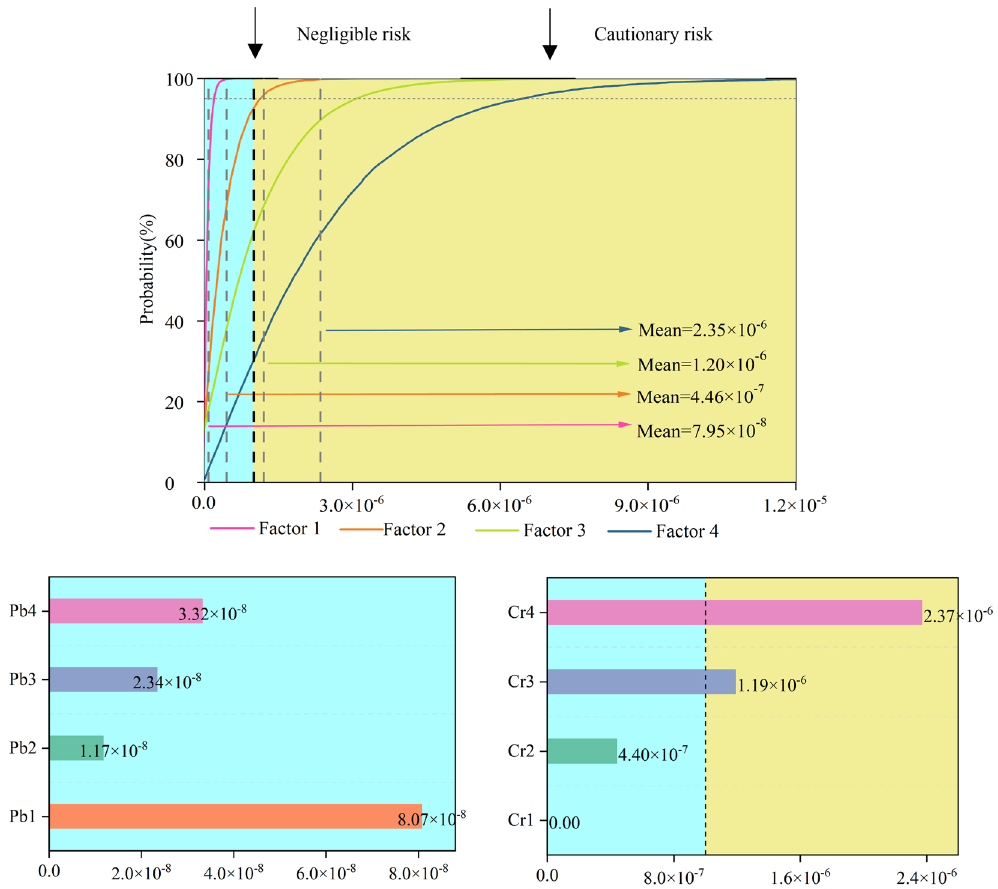
Figure 4. Probability distribution of total carcinogenic risk for children and carcinogenic risk from heavy metals based on each source. Software: Origin2021. URL: https:// www. origi nlab.